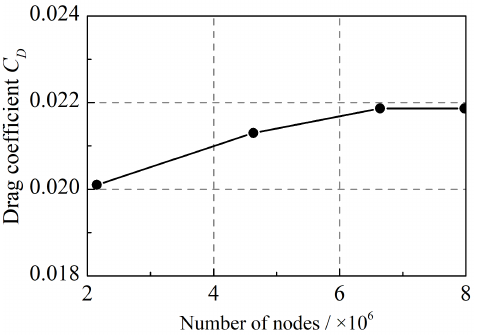
Figure 14. Result of grid independence validation on the drag